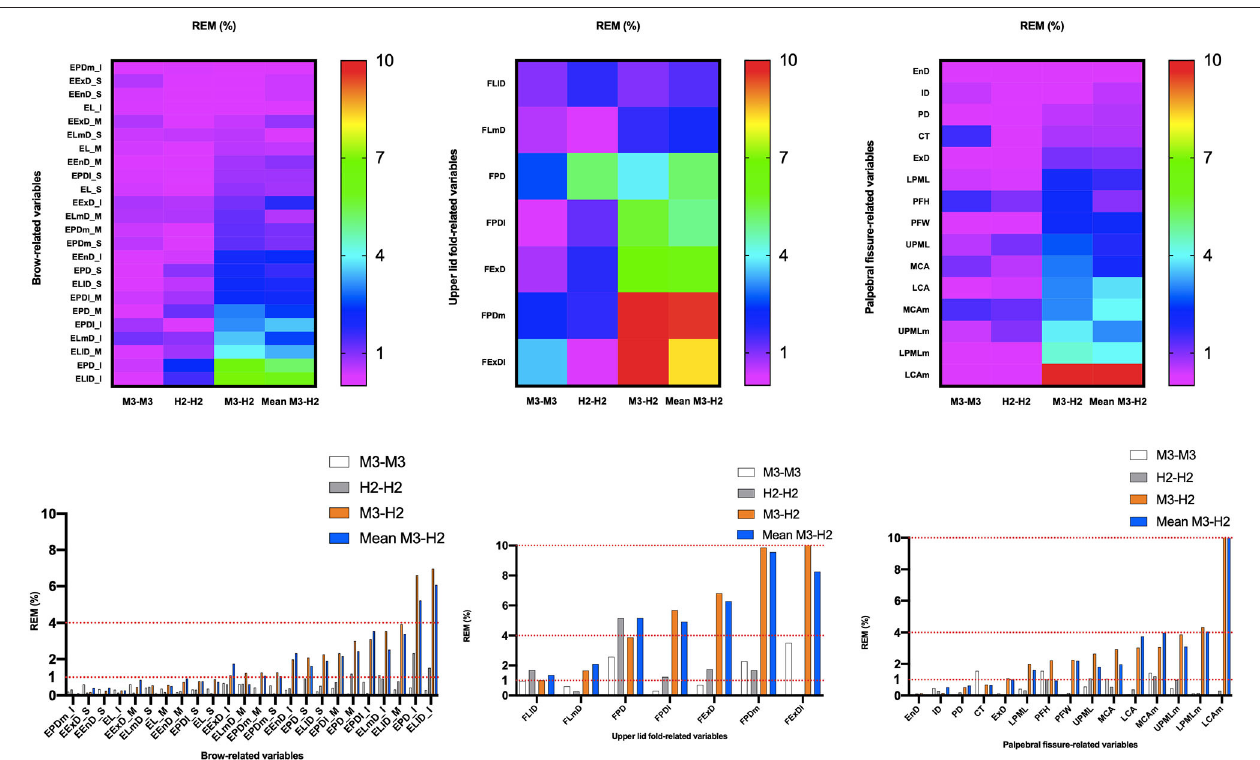
FIGURE 5 | Intra- and inter-device relative error of measurement (REM) for all periocular region measurements of 3D images. Reliability category criteria were as follows: excellent, < 1%; very good, 1–3.9%; good, 4–6.9%; moderate, 7–9.9%; and poor, > 10%.